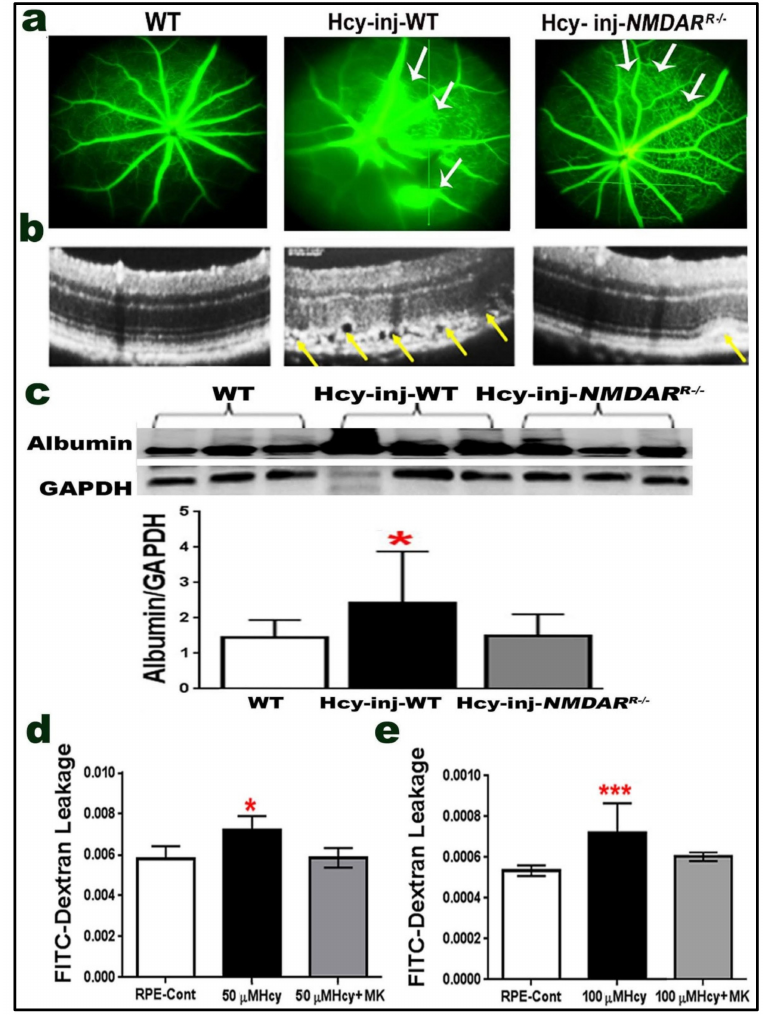
Figure 5. Knocking down the NMDAR in RPE cells ( NMDAR R − / − mice) protects retina from Homocysteine-induced blood retinal barrier (BRB) dysfunction and choroidal neovascularization (CNV). C57BL6 mice with/without Hcy-thiolactone intravitreal injection or genetic inhibition of NMDAR ( NMADR R − / − ) were evaluated 72 h after injection of Hcy by ( a ) FA evaluation, show- ing normal well-formed vessels in WT mice; however, angiograms for Hcy-injected mice retinas showed marked vascular leakage that appeared as diffused hyperfluorescence (white arrows), which was markedly reduced after knocking down NMDAR in RPE ( NMDAR R − / − ) mice. ( b ) OCT ex- amination presenting normal appearance in the WT mice’s retina, marked interruption of retinal morphology with hypo-reflective subretinal lucency, focal hyper-reflective spots, and choroidal neovascularization (yellow arrows) in Hcy-injected mouse retinas. Knocking down NMDAR in RPE was able to reduce the retinal disruption via CNV and improved retinal structure after Hcy injection in NMDAR R − / − mice (yellow arrows), ( n = 6 mice/group). ( c ) Reduced vascular leakage after knocking down NMDAR in RPE was confirmed by measuring the albumin leakage in the retinas by western blotting, which was significantly increased in the Hcy-injected mice eye but reduced to normal level in Hcy-injected NMDAR R − / − mice * p < 0.05. Improvement of retinal morphology and CNV induction was further evaluated by assessment of retinal thickness in Hcy-injected mice. ( d ) FITC dextran flux through the RPE monolayer, which revealed a significant increase in FITC dextran leakage in 50 µ M Hcy-treated RPE cells and decreased by MK801 treatment. ( e ) FITC dextran flux through the RPE monolayer, which revealed a significant increase in FITC dextran leakage in 100 µ M Hcy-treated RPE cells and decreased by MK801 treatment. ( n = 6 mice per group) for cells ( n = 4). * p < 0.05 and *** p <